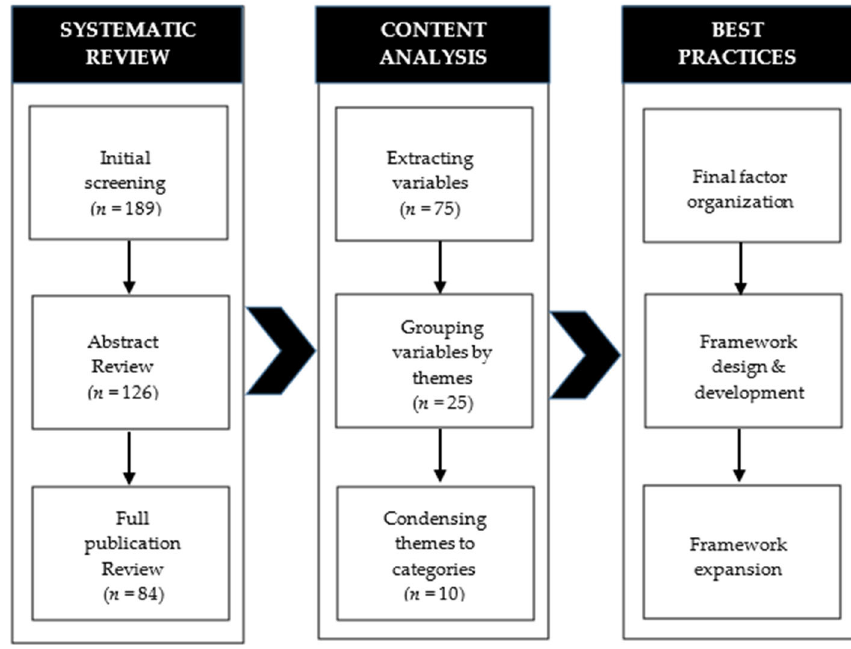
Figure 1. Study design.